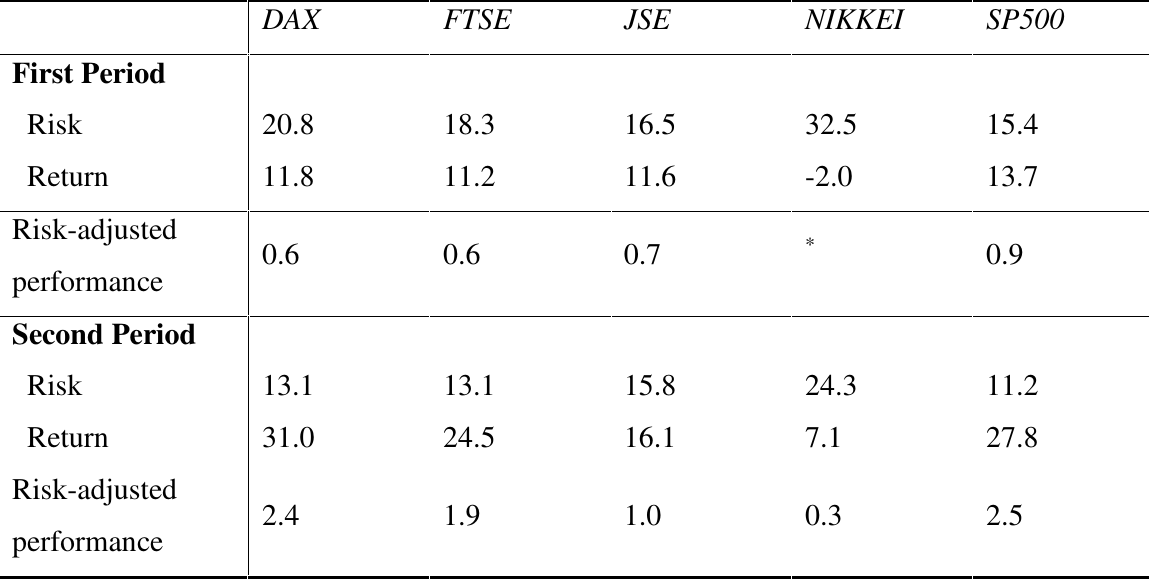
Table 9. Two-period performance